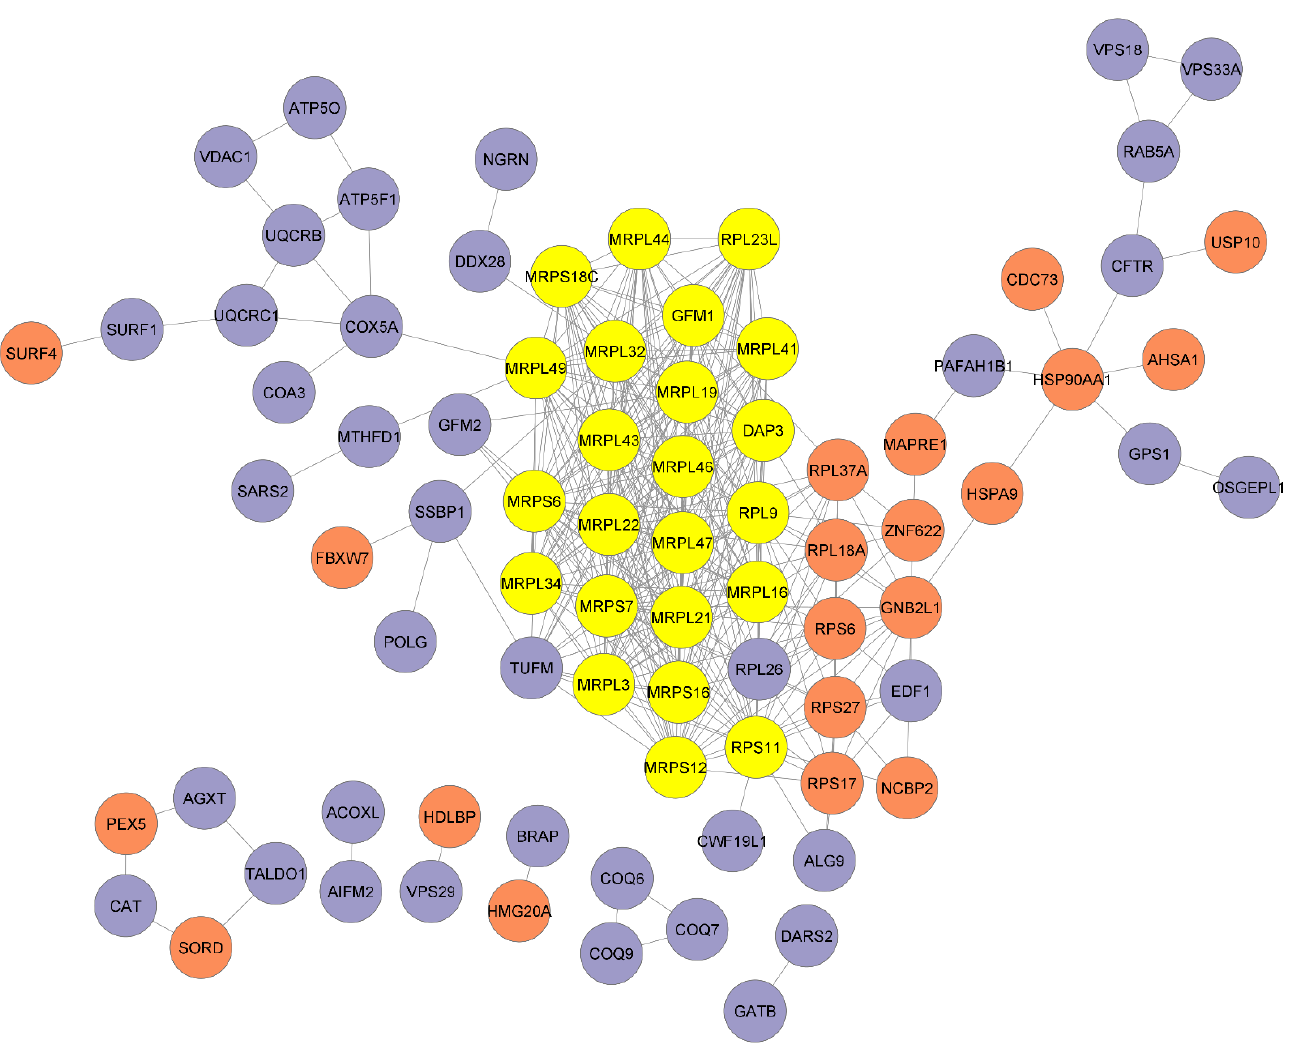
Figure 4. Cluster with the highest MCODE score is shown in yellow. Amyloid toxicity protective genes can be seen in blue and enhancer genes can be seen in salmon.